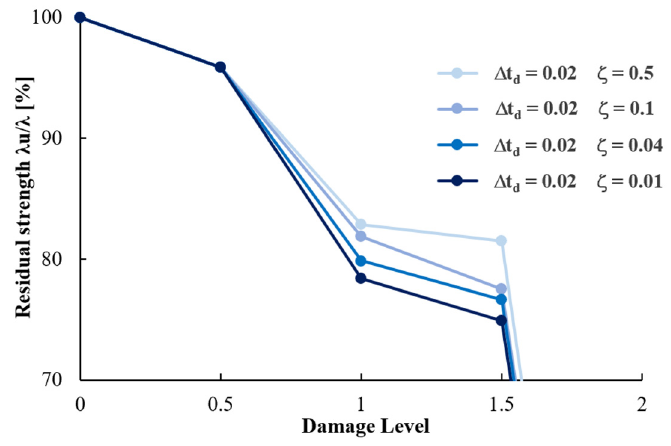
Figure A7. Robustness curves for 2D RC frame structure for location 1: effect of variation of damping ratio. Δ t d values are expressed in seconds.